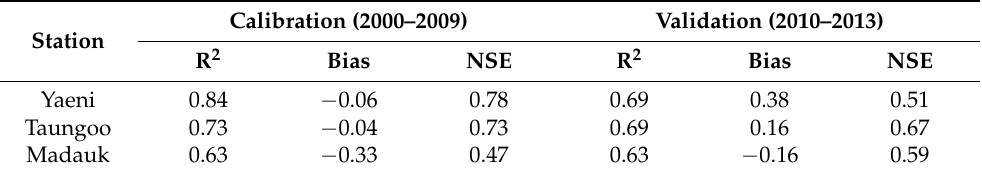
Figure 8. Simulation of monthly flows at ( A ) Yaeni, ( B ) Taungoo, and ( C ) Madauk stations using APHRODITE and bias-corrected APHRODITE (BC_APHRODITE). Table 7. Calibration and validation statistics estimated using bias-corrected APHRODITE in the Sittaung river